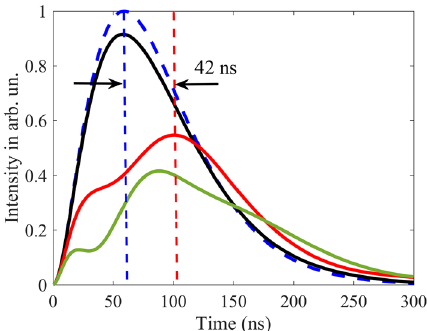
Figure 11. Normalized time dependence of the intensity of 14.4-keV Lorentz-squared single-photon wave 59 ns . packet Eq. (47) from ESRF SMS with a duration of 100 ns and peak intensity at the moment t ( in ) max = 1.88 γ 21 , γ 4.7 γ 21 , The blue dashed line corresponds to the incident wave packet, Eq. (47), under B S = = 0.56 MHz . Other lines correspond to the photon waveform at the exit from the 57 Fe absorber γ 21 ( 2 π) = 6 with amplitude R 1 0.38 (cid:31) , Eq. (14), ( p 1 2.4 , Eq. (13)), plotted using γ 21 vibrating at the frequency � = = = (cid:31) 13 ; the green line numerical integration of Eq. (33). The red line corresponds to the absorber optical depth T a = (cid:31) 30 ; the black solid line is plotted for T 1 corresponds to T a a = =